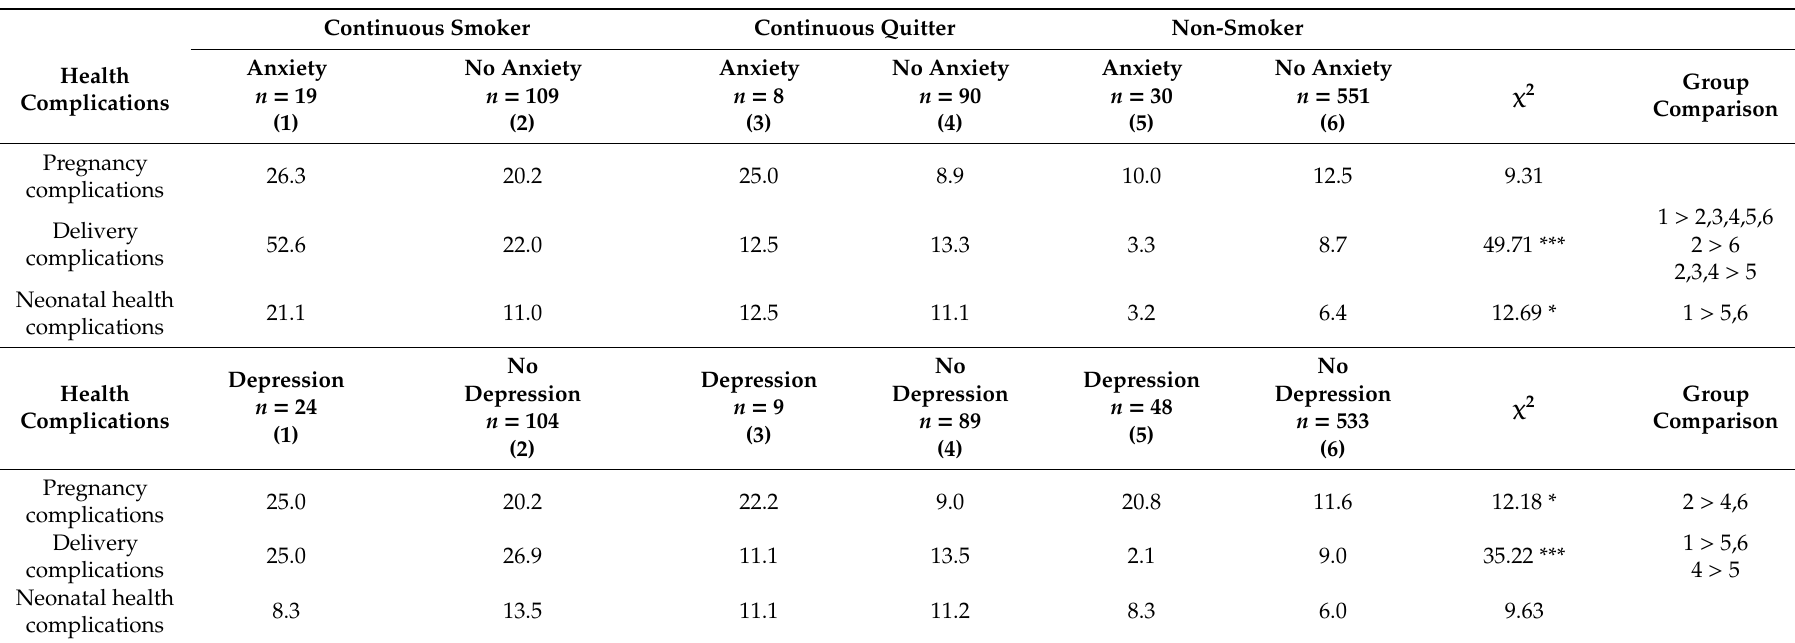
Table 3. Interaction e ff ects between consumption status and anxiety or depression on health